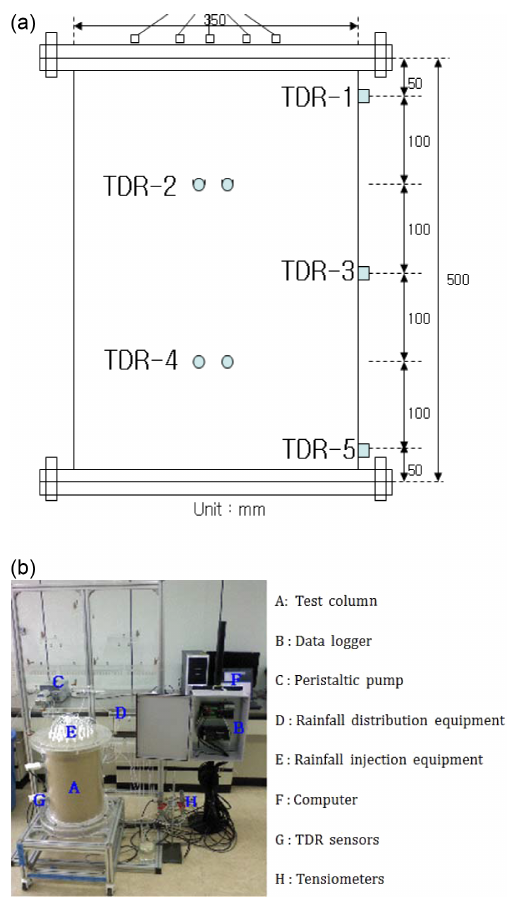
Figure 4. Unsaturated soil column test equipment. (a) Schematic description of the soil column and (b) composition of the